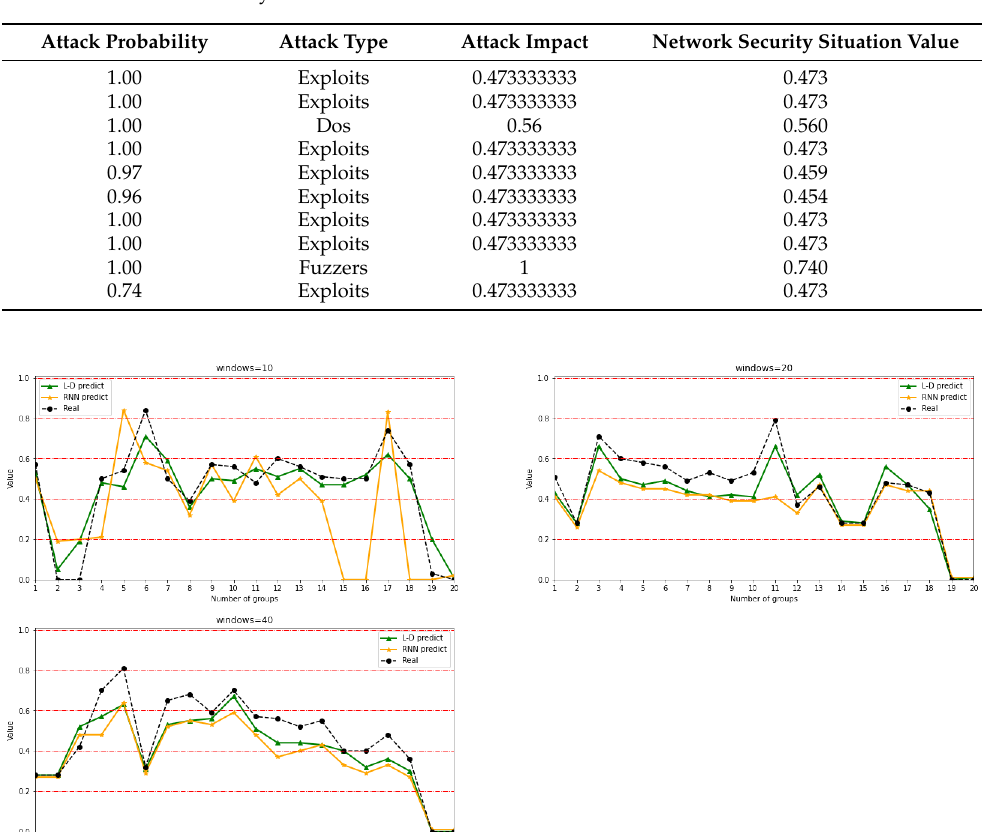
Figure 10. 20 groups of network security situation values under different window sizes.